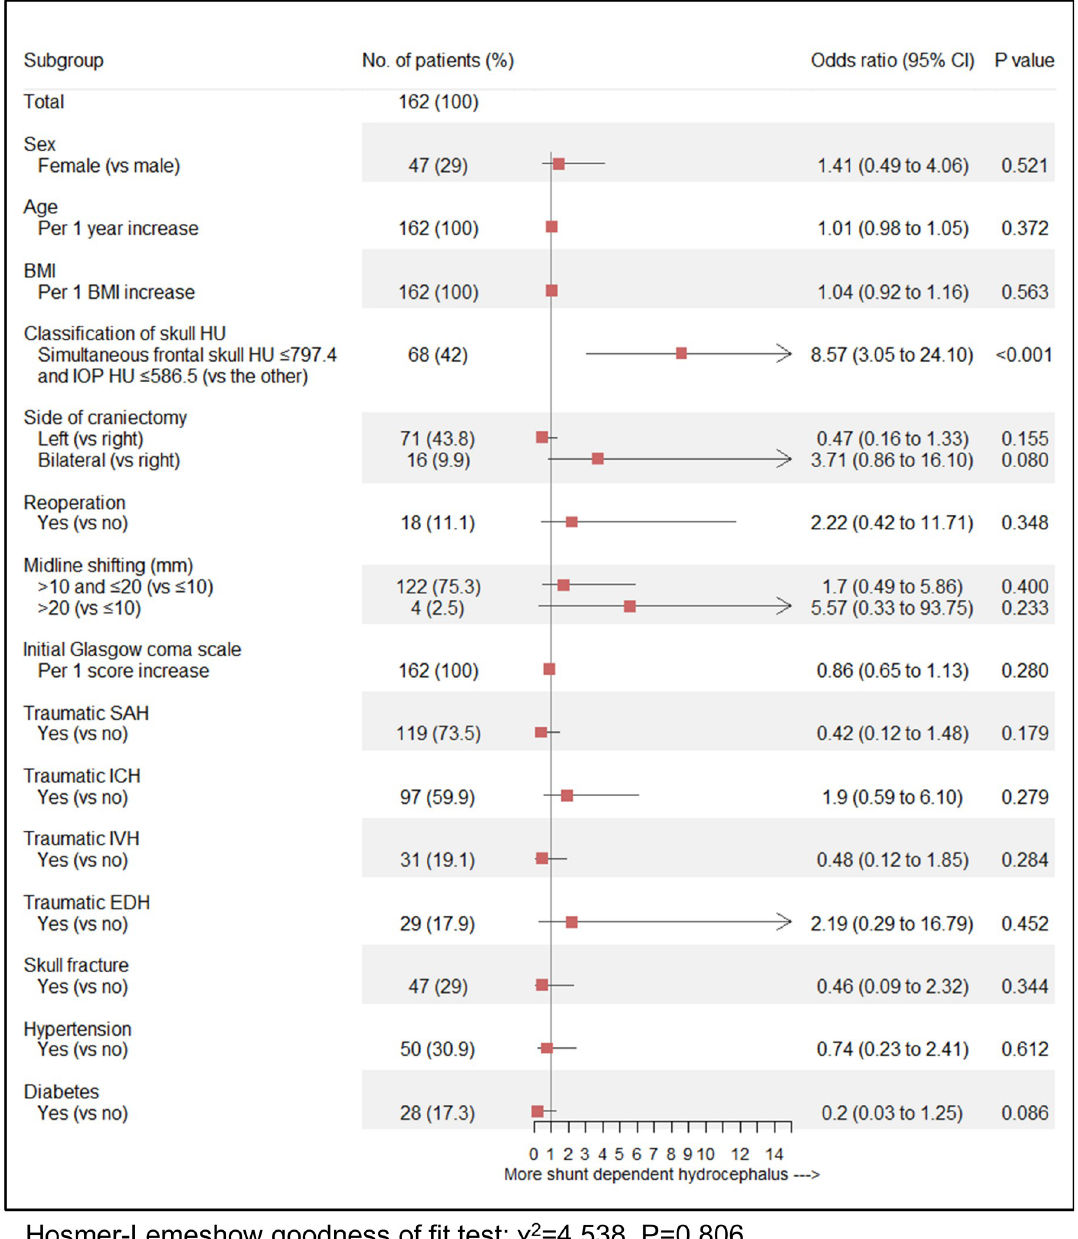
Fig 4. Forest plot of estimates from multivariable logistic regression analysis for prediction of SDHC development according to potential predictive factors (adjusted for sex, age [continuous variable], BMI [continuous variable], group with simultaneous frontal skull HU � 797.4 and IOP HU � 586.5, side of craniectomy, reoperation, midline shifting, initial GCS [continuous variable], traumatic SAH, ICH, IVH, EDH, skull fracture, hypertension, and diabetes). SDHC = shunt-dependent hydrocephalus; BMI = body mass index; HU = Hounsfield unit; IOP = internal occipital protuberance; GCS = Glasgow coma scale; SAH = subarachnoid hemorrhage; ICH = intracerebral hemorrhage; IVH = intraventricular hemorrhage; EDH = epidural hematoma; CI = confidence